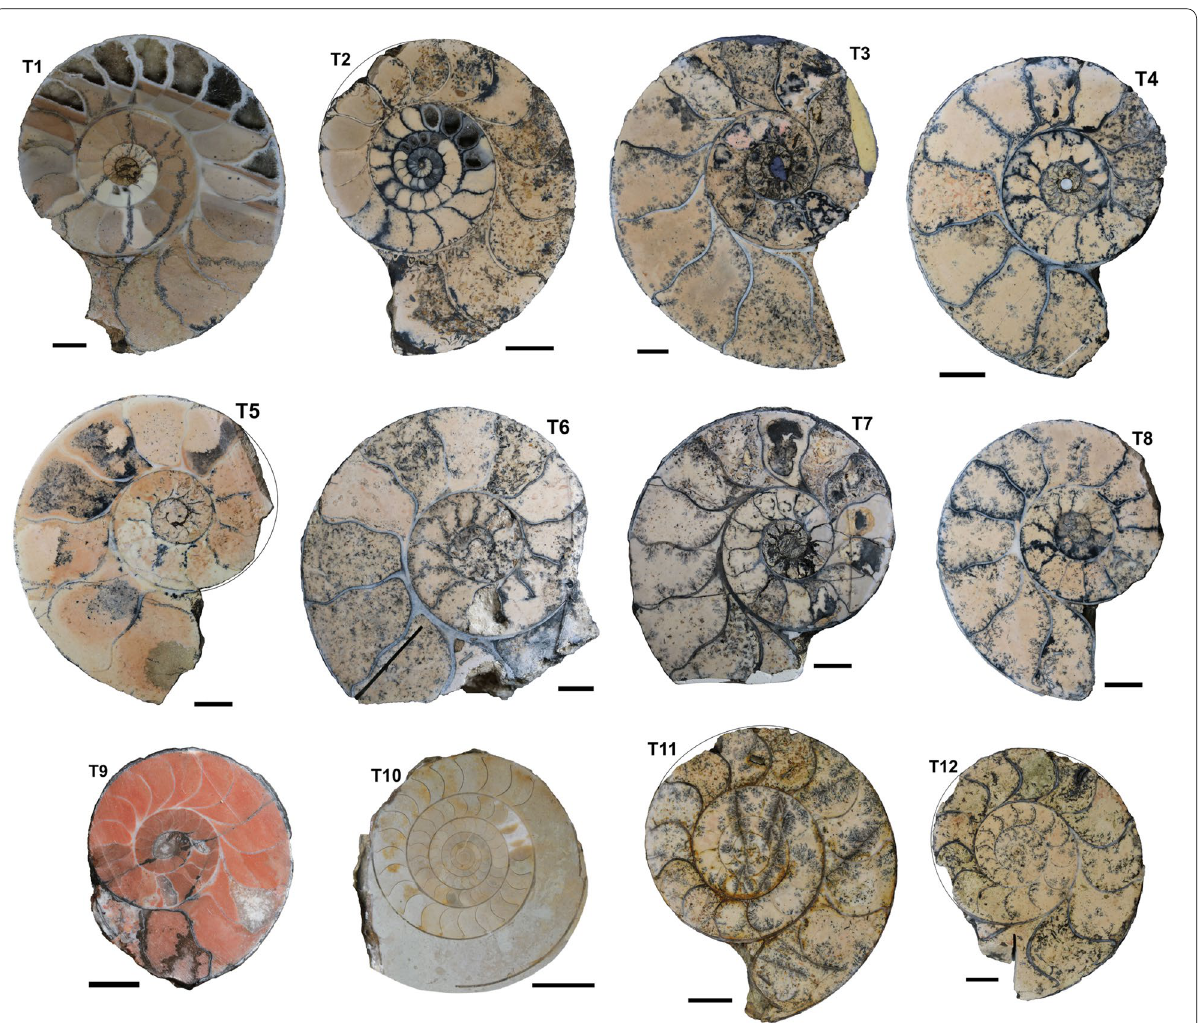
Fig. 1 Triassic ammonoids (for details see Table 1). (T1) Monophyllites sp. (PIMUZ 37660), (T2) Halorites sp. (PIMUZ H.s.T 20), (T3) Rhacophyllites neojurensis (PIMUZ 37661), (T4–T8) Discophyllites ebneri , (T5) (PIMUZ 37658), (T6) (PIMUZ R.n. 34), (T7) (PIMUZ R.n. 29), (T8) (PIMUZ R.n. 21), (T9) Megaphyllites sp., (PIMUZ 37659), (T10) Arcestes sp. (PIMUZ 019104 X10 RA4a), (T11) Cladiscites sp. (PIMUZ 37662), (T12) Cladiscites sp. (PIMUZ 37663). Scale bar 1 =